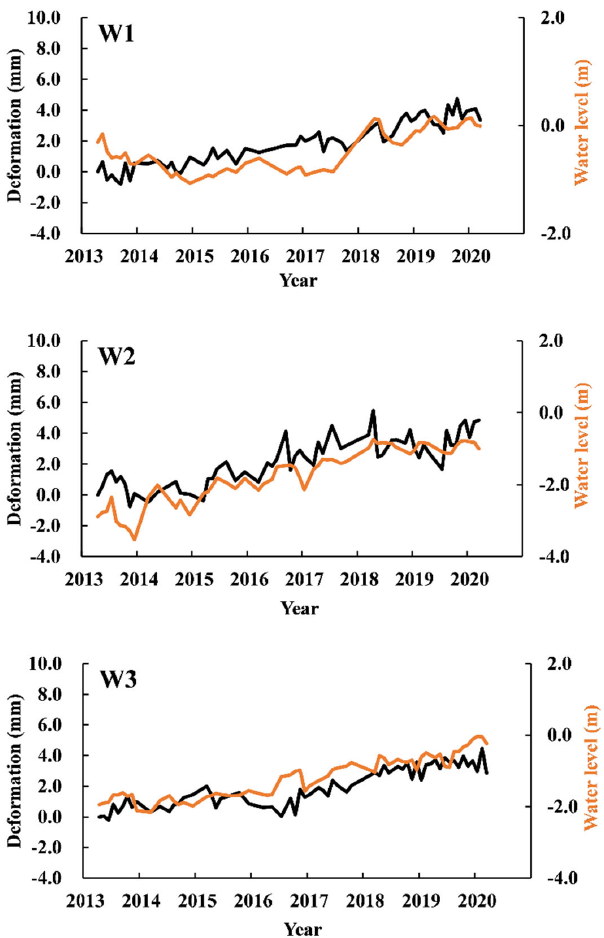
Figure 11. Curve of time series groundwater level and ground deformation in Shanghai from 2013 to 2020. Plots ( W1 – W3 ) shows the groundwater level and the corresponding ground deformation respectively around the three wells, labeled as W1, W2, W3.